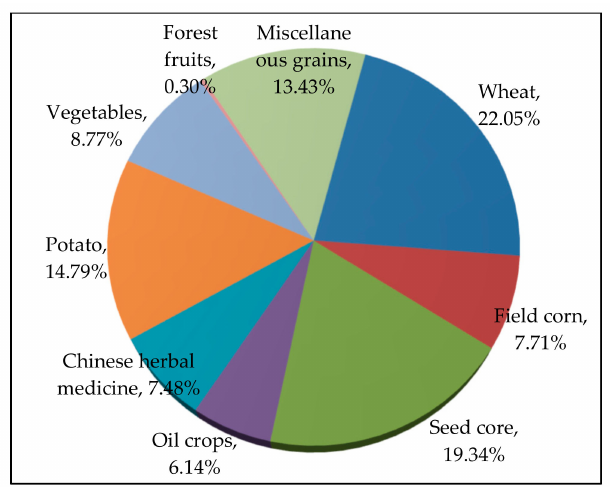
Figure 6. Proportion of planting types of scale management